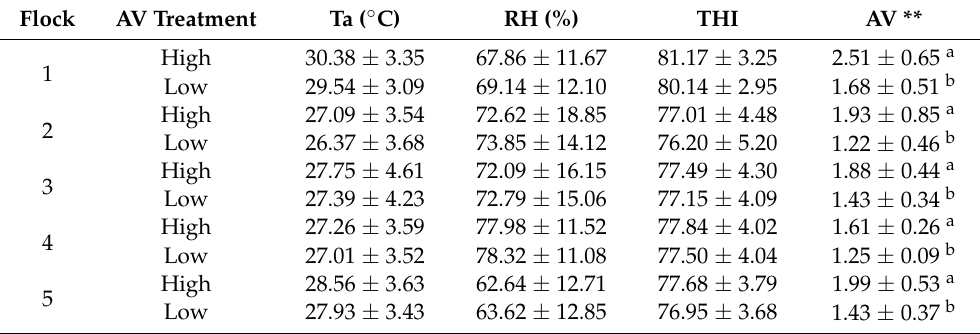
Table 4. Average environmental conditions in chambers during the image data collection